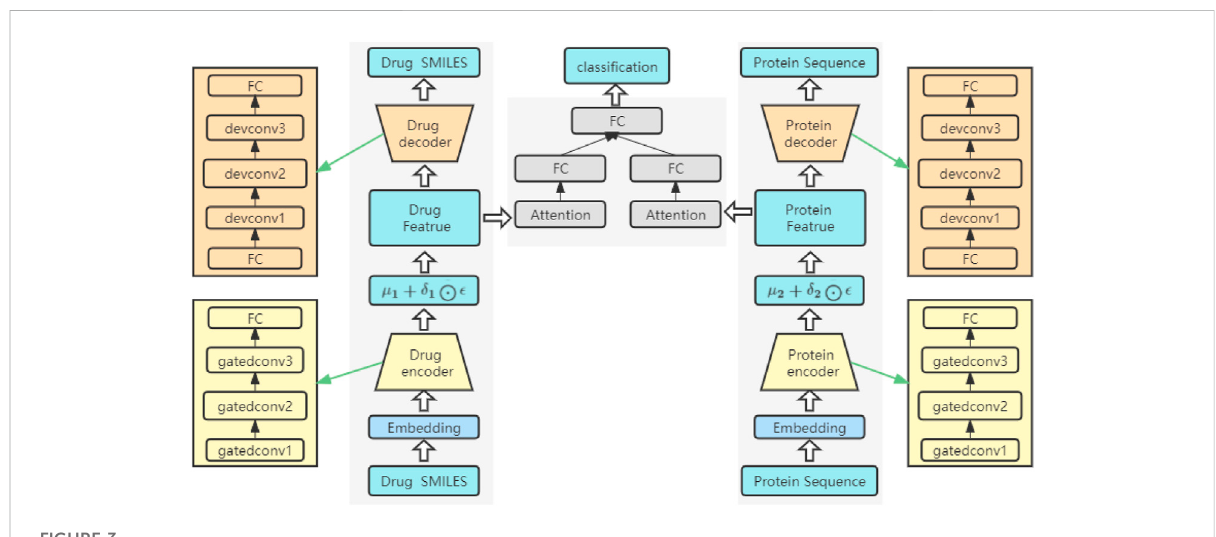
FIGURE 3 The framework structure of the